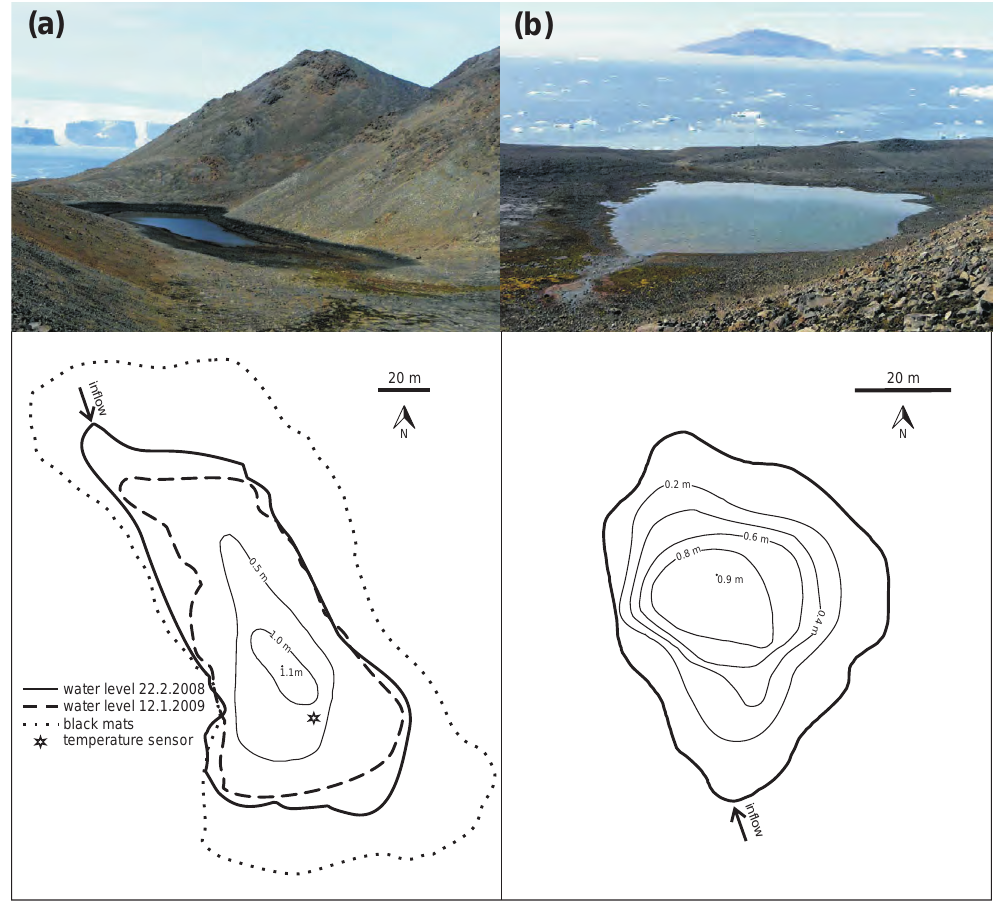
Figure 2. Bathymetric parameters of lakes 1 (a) and 2 (b) together with marked lines of water level and maximum extent of the photosynthetic microbial mat littoral belt in lake